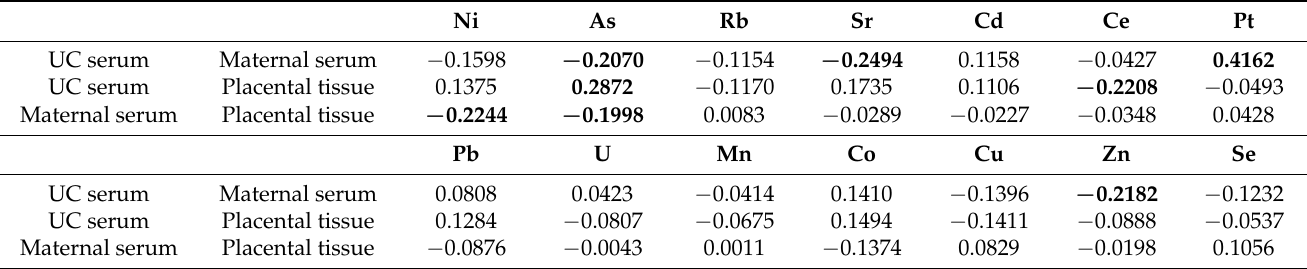
Table 2. Results of the Spearman’s rho ( ρ ) correlation analysis between different types of clinical samples. Statistically significant values are given in